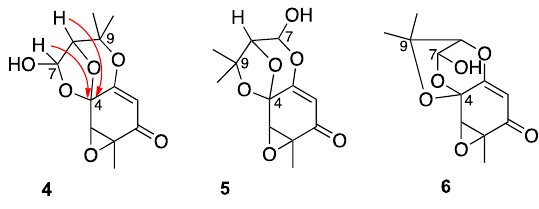
Chart 3. Candidate diastereomers of acremine P.